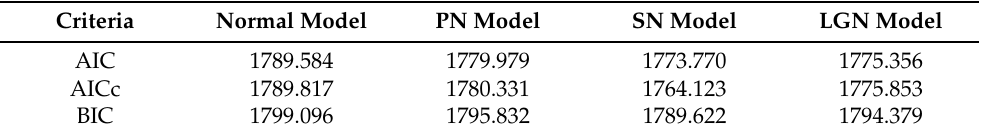
Table 5. AIC, AICc, and BIC for normal, PN and LGN linear models.